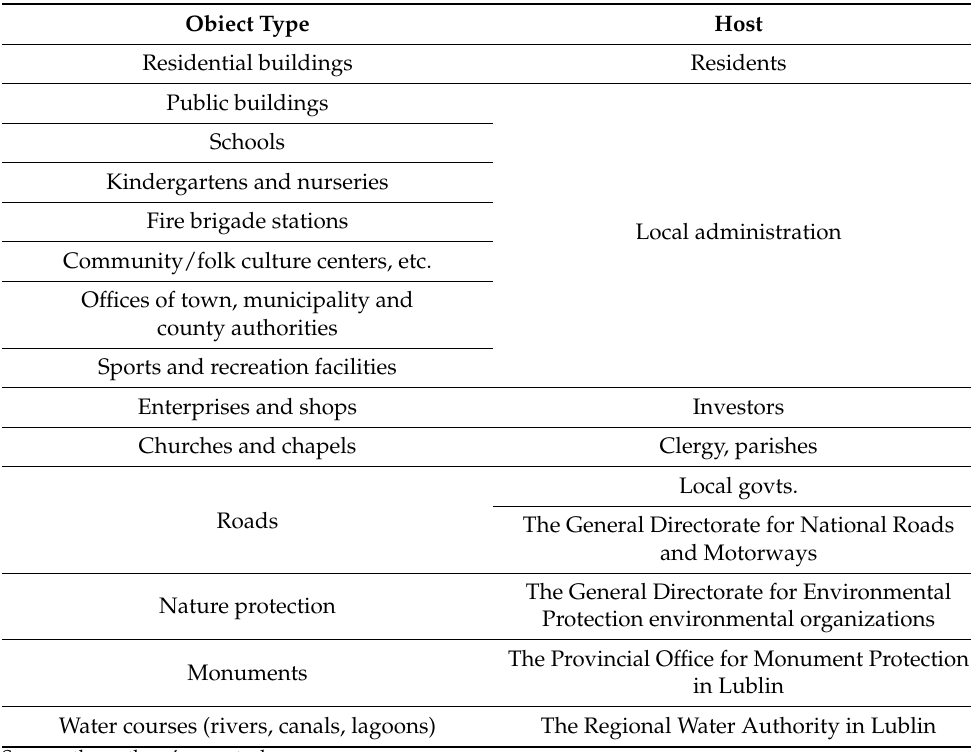
Table 2. The list of types of objects and related hosts for the Cyców LW Bogdanka mining area.